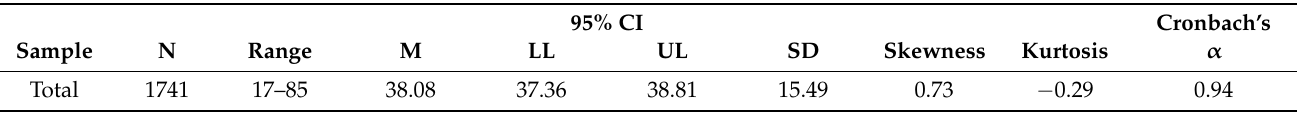
Table 3. Descriptive statistics for coronavirus-related PTSD risk among university students in six countries during the second wave (October–December 2020) of the COVID-19 pandemic.